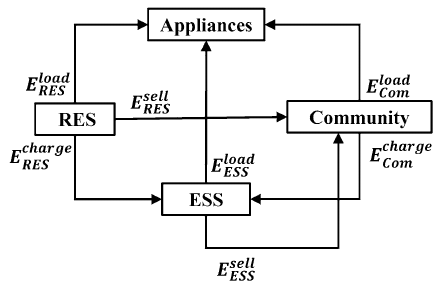
Figure 2. Energy flows in a smart home with RES and